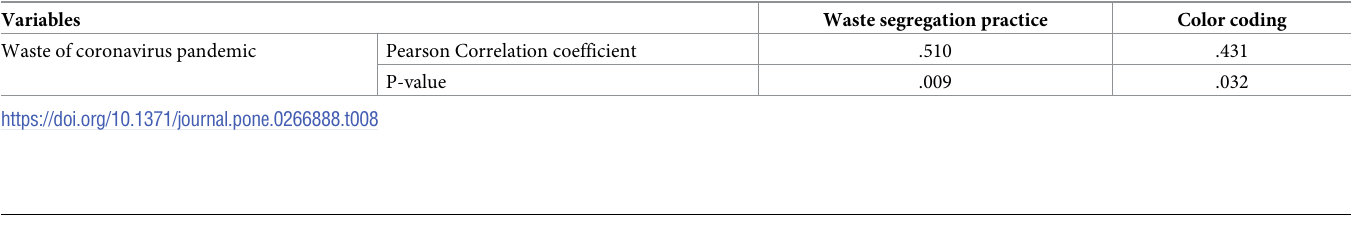
Table 8. Bivariate correlation analysis of waste of coronavirus pandemic with waste segregation practice and availability of color coding.